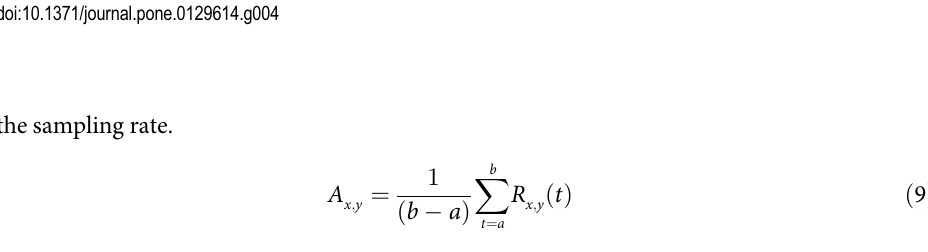
Fig 4. The signal parameters that can be obtained from the processed signal. See text for